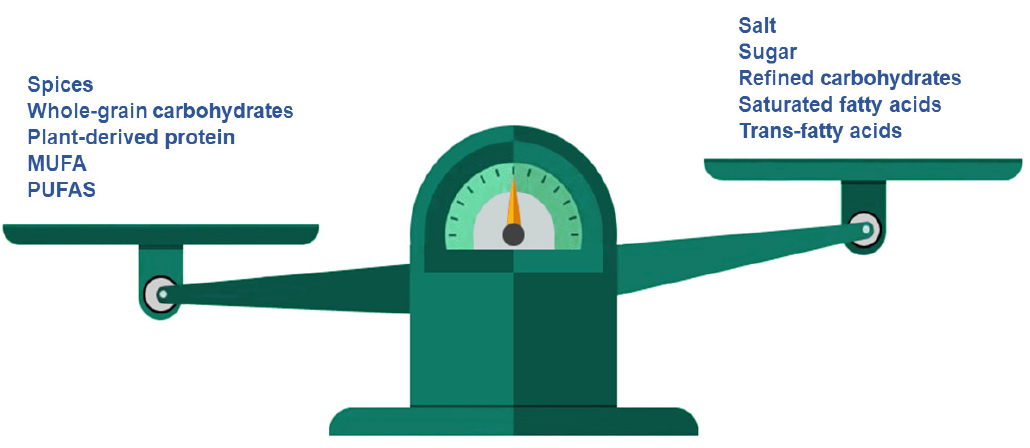
Figure 3. Reformulation proposal for healthier bakery and pastry products *. * Potassium chloride, monosodium glutamate, nucleotids, polysaccharides, natural sweeteners, positive allosteric modulators (PAMs), caprenin, salatrin and olestra may be used to enhance flavour.